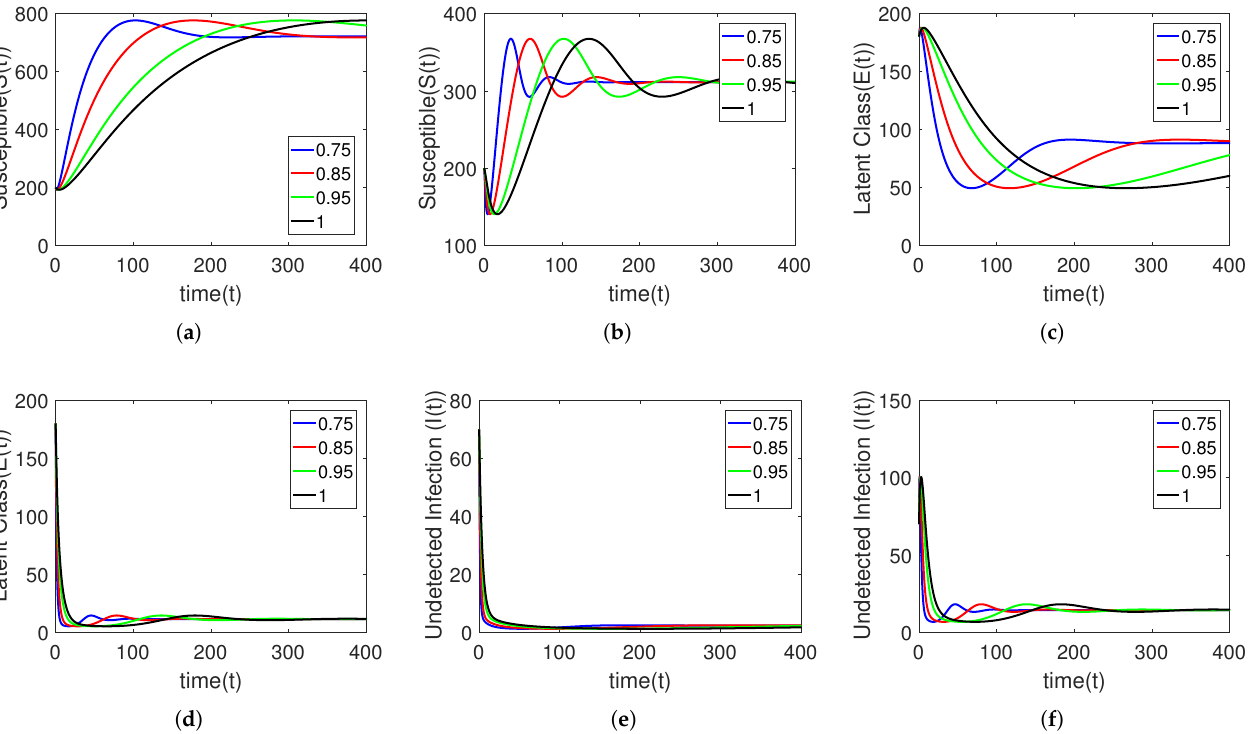
Figure 17. Graphical view ( a – f ) of first three classes on different arbitrary orders γ = 0.75,0.85,0.95,1 for initial data and time duration for TB model by taking the value of α =